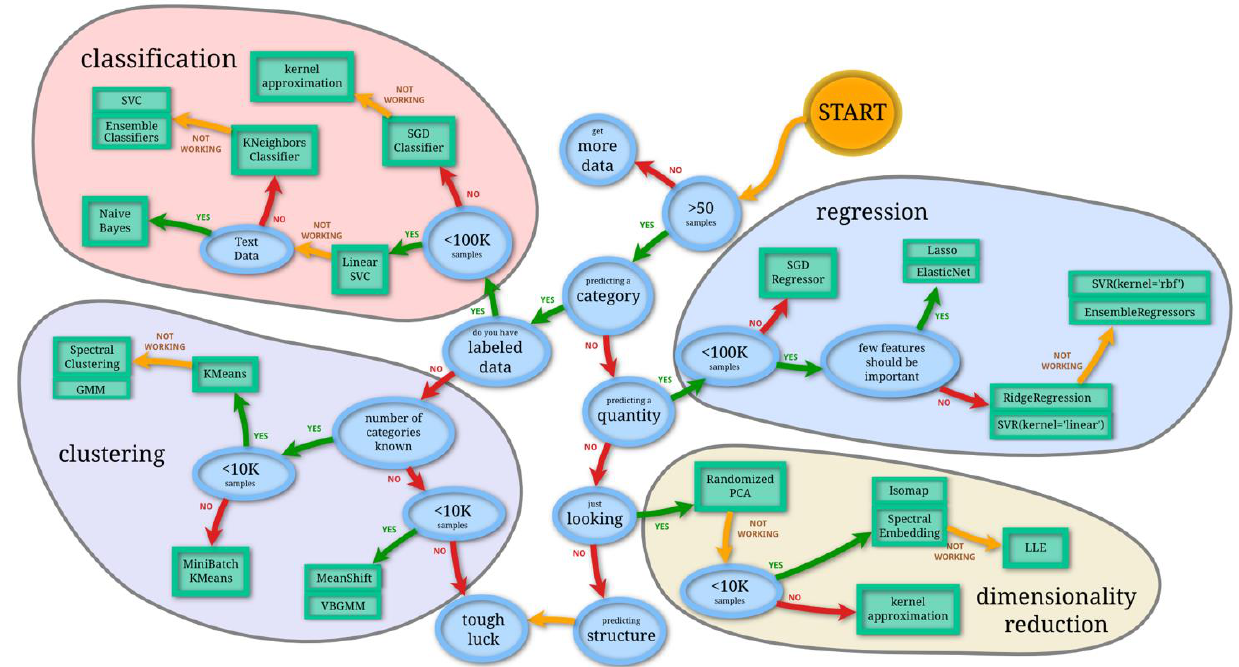
Figure 2. Selecting the right machine learning technique [29].